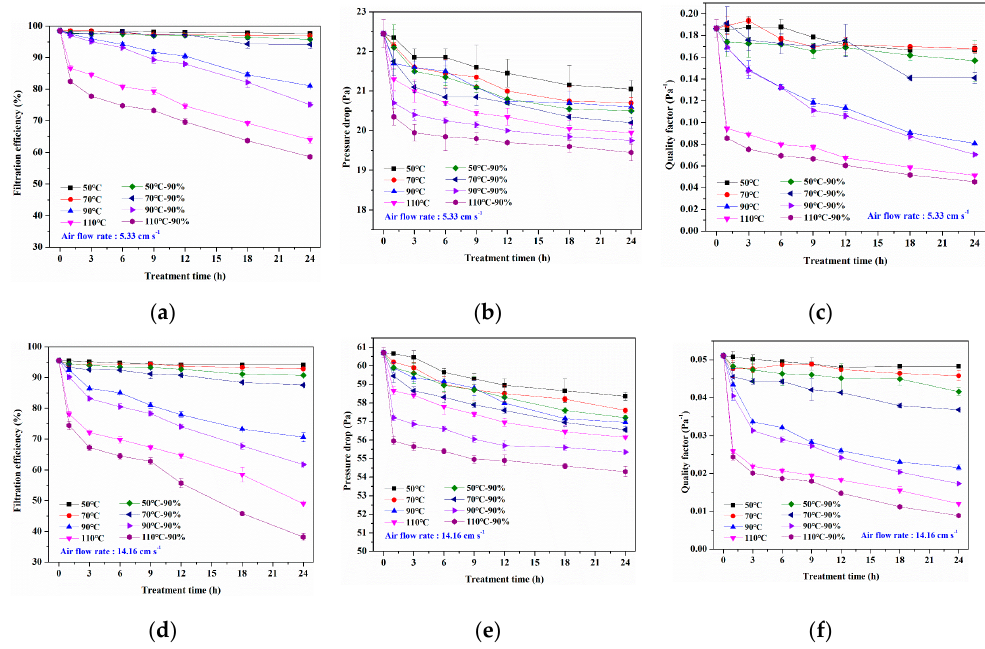
Figure 7. ( a ) Filtration efficiency decay, ( b ) pressure drop, and ( c ) quality factor of samples were tested at an air flow rate of 5.33 cm s − 1 . ( d ) Filtration efficiency decay, ( e ) pressure drop, and ( f ) quality factor at an air flow rate of 5.33 cm s − 1 . ( d ) Filtration e ffi ciency decay, ( e ) pressure drop, and ( f ) quality factor value of samples were tested under an air flow rate of 14.16 cm s − 1 . value of samples were tested under an air flow rate of 14.16 cm s − 1